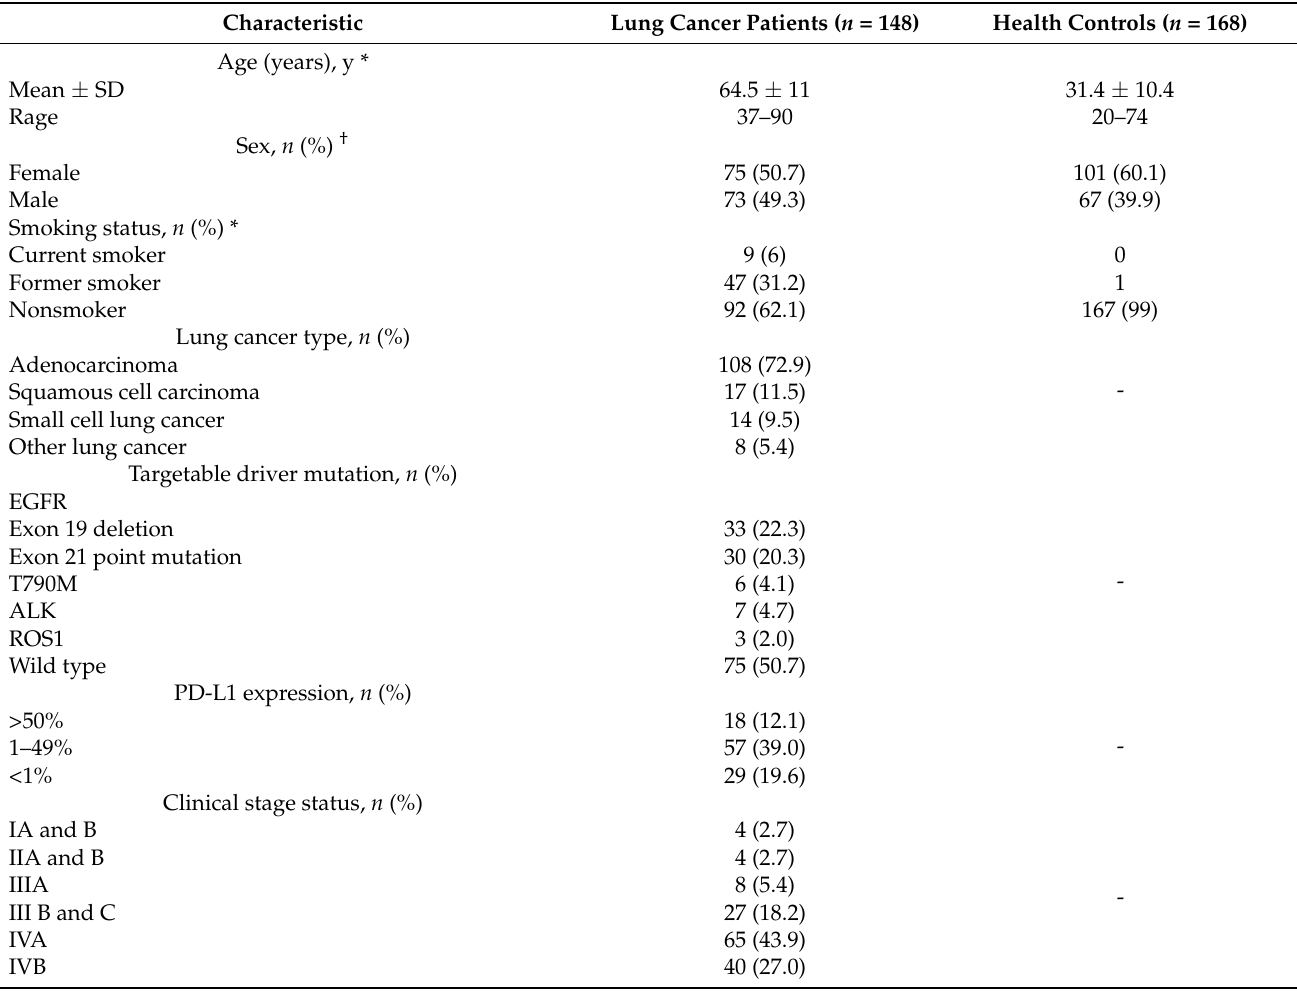
( n = 43) of healthy volunteers of NCTU were grouped closely (middle red and green in the color bar on the left). Healthy volunteers of NTUH were more spread out (blue in the color bar on the left). The hierarchical clustering identified several VOC groups (the dendrogram on the top), where two groups contained dominant features for distinguishing between cancer cases and healthy controls. Ethanol, formic acid, ethanedial, methanol, acetone, butane, and hexane (the far-left brown in the first color bar at the top) had higher values in cancer cases than in healthy controls. Another group of VOCs, including benzoic acid and beta-caryophyllene, (the far-right brown in the first color bar on the top), showed an extremely low concentration for most healthy controls. All these dominant VOCs, except hexane, were significantly different between lung cancer cases and healthy controls. Hexane and beta-caryophyllene were not significantly different between the NCTU and NTUH. Table 2. Characteristics of patients with lung cancer and healthy volunteers of the study. Characteristic Lung Cancer Patients ( n =